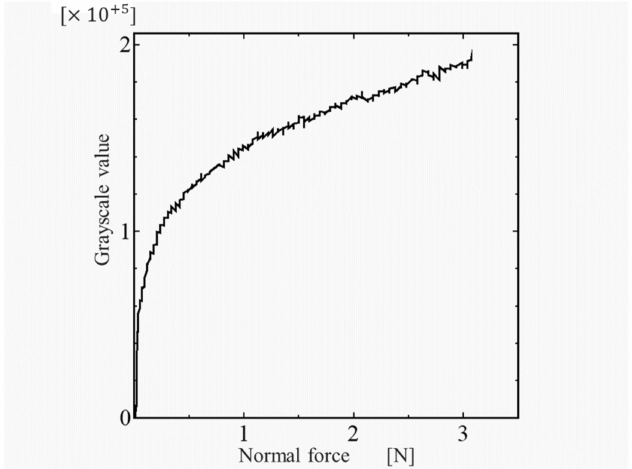
Figure 9. Result of normal force test: In the very low normal force range of 0 to 0.1 [N], the relationship is almost linear, with high inclination; in the middle range from 0.1 to 1 [N], the relationship shows considerably large nonlinearity. Over the 1-N range, the relationship is treated as a linear curve; normal force is estimated from the grayscale value obtained from the tactile sensor if suitable regression is applied to the